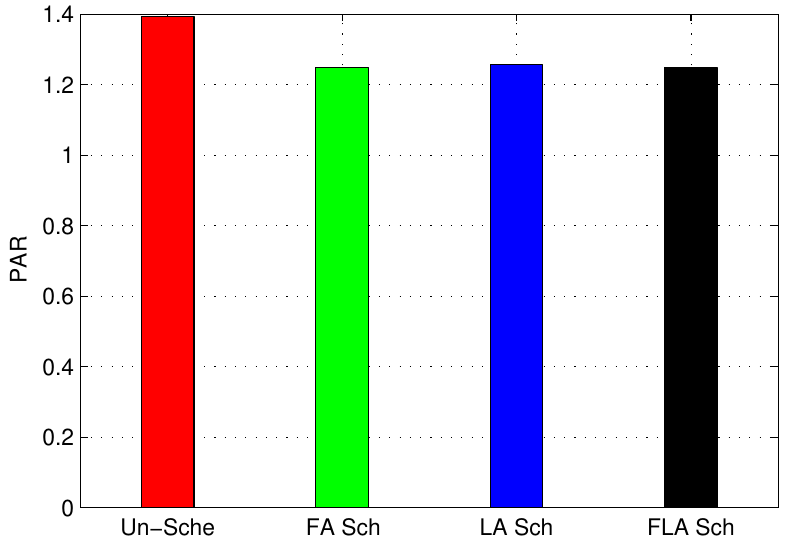
Figure 9. Peak to Average power Ratio (PAR).